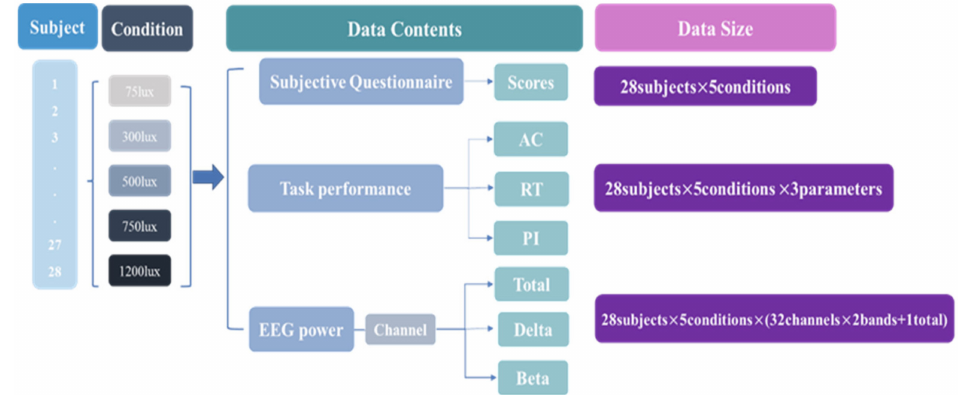
Figure 9. Data structure.